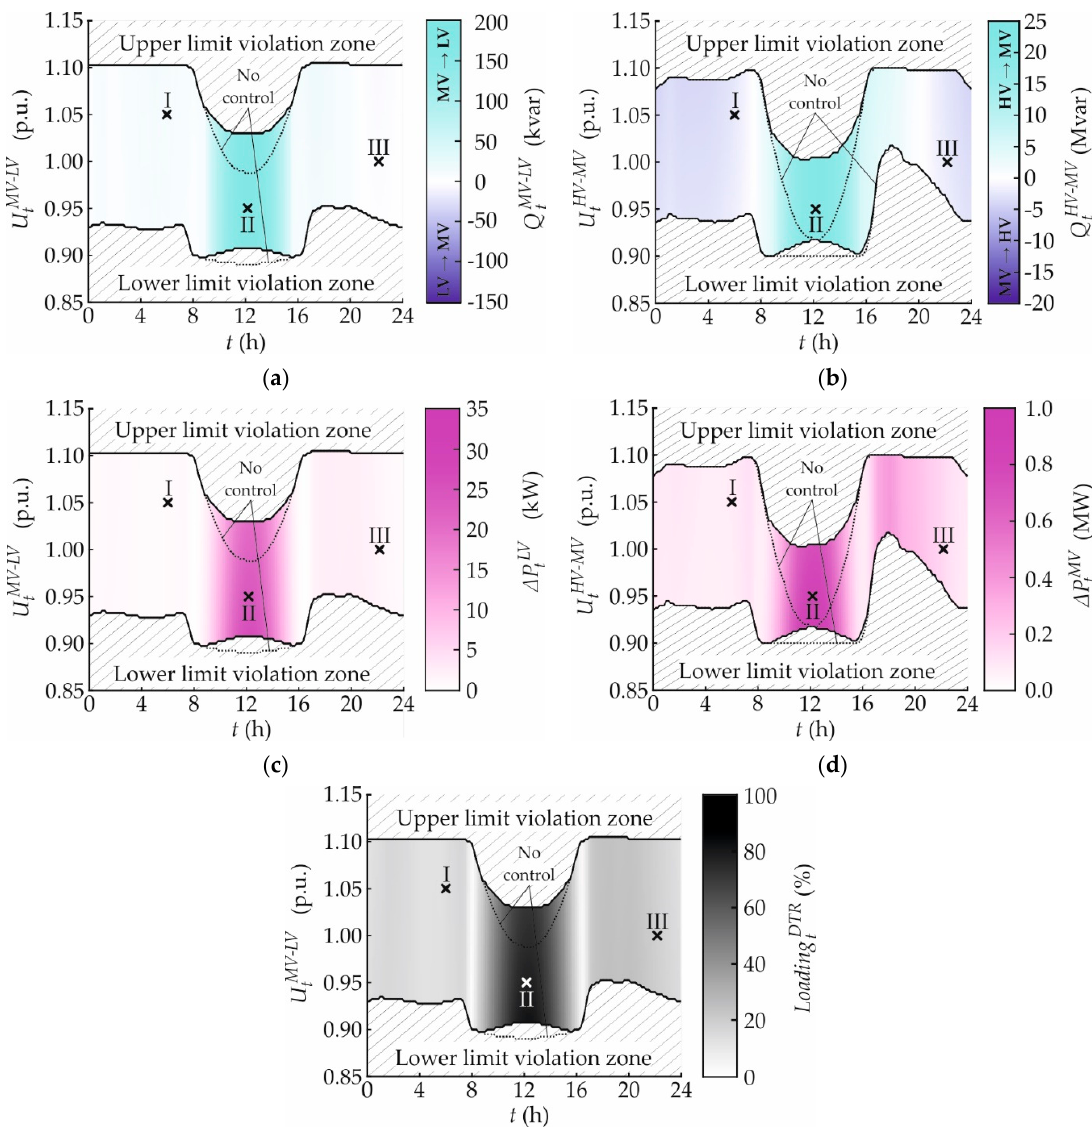
Figure 16. Daily behavior of the test link chain for various boundary voltages and the cos φ ( P ) local control: ( a ) reactive power exchange over the MV − LV boundary (rural LV_Link-Grid); ( b ) reactive power exchange over the HV − MV boundary; ( c ) active power loss within the rural LV_Link-Grid; ( d ) active power loss within the MV_Link-Grid; ( e ) DTR loading (rural LV_Link-Grid).